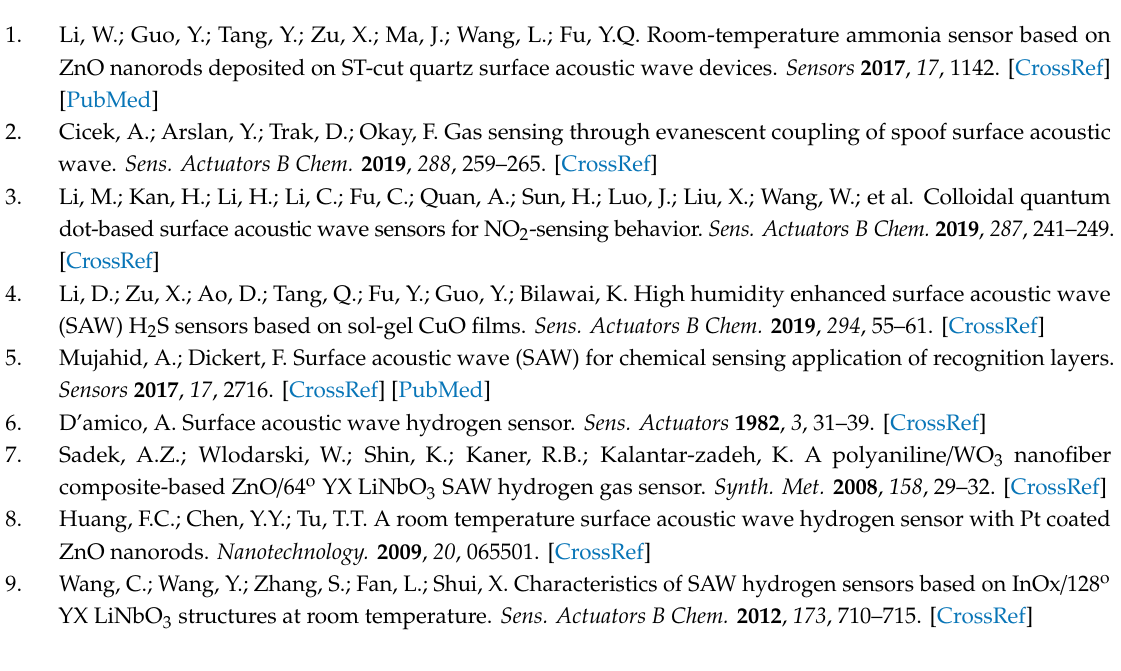
Figure 10. The selectivity testing of the proposed Pd-Ni alloy thin-film coated sensing device.